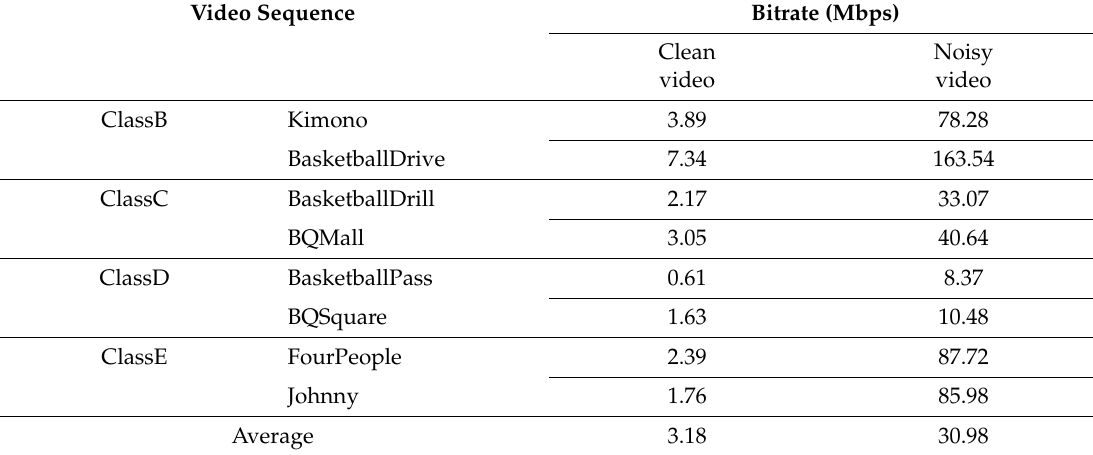
Table 1. Comparison of processing time for noisy video